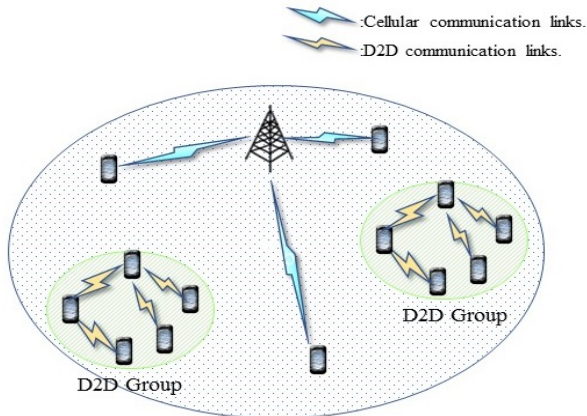
Figure 1. An example environment for D2D communication mode.